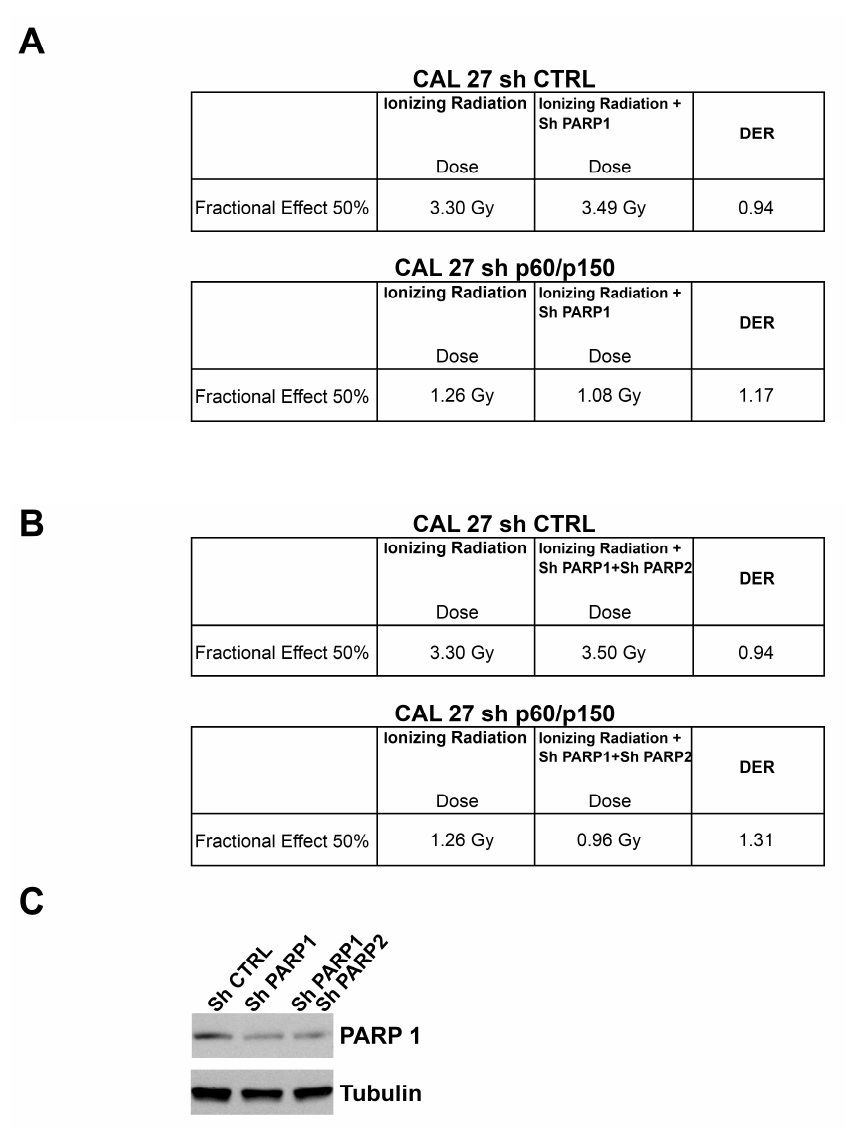
Figure 5. ( A , B ) The Dose Enhancement Ratio (DER) at 50% of the e ff ect refers to the ratio between the dose with radiation alone and the dose with radiation + shPARP1 alone or in combination with shPARP2 for the same biological e ff ect. If the DER is greater than one, then the silencing of PARP1 / 2 is functioning as a radiosensitizer. If the DER is less than one, the PARP silencing acts as a radioprotector. In the table are shown DER values at 50% e ff ect for CAL 27 (sh CTRL vs. sh p60 / p150). ( C ) The PARP1 depletion was assessed by Western blot. Tubulin is shown as loading